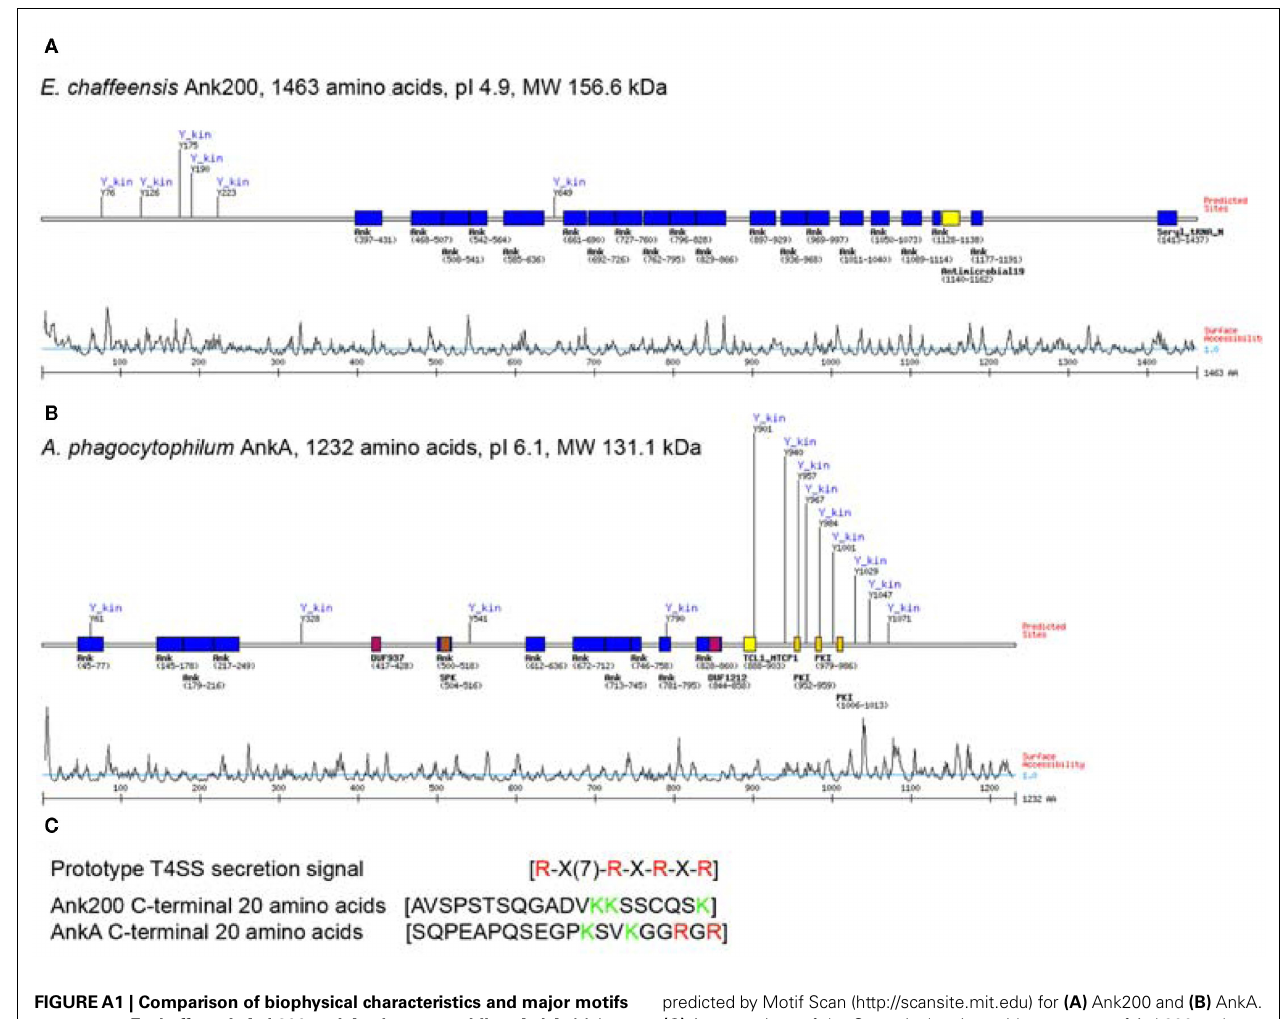
FIGUREA1 | Comparison of biophysical characteristics and major motifs present on E. chaffeensis Ank200 and A. phagocytophilum AnkA. Major motifs and their relative positions in terms of amino acid sequences as